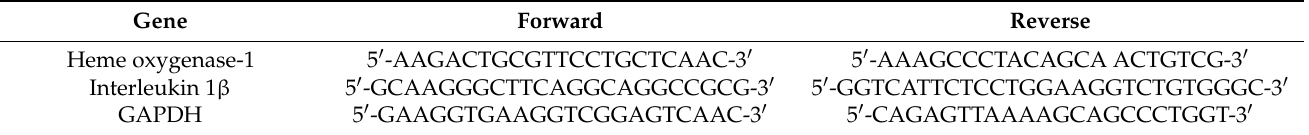
Table 1. List of primers used for